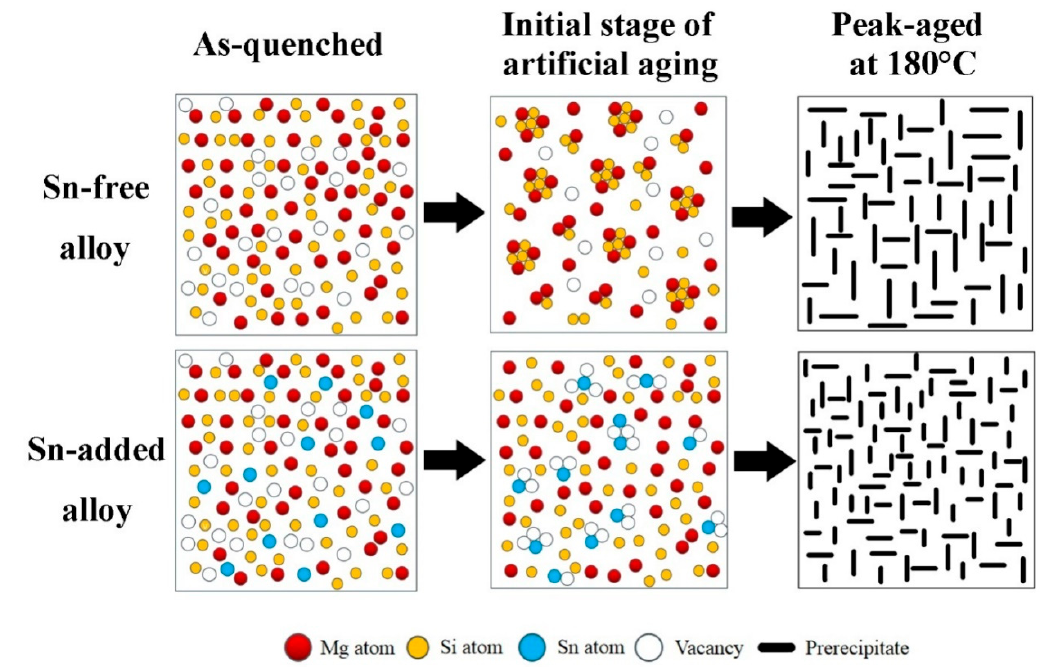
Figure 8. The schematic illustrations of cluster and precipitate evolution in the Sn-free and Sn-added alloys during the artificial aging at 180 °C.